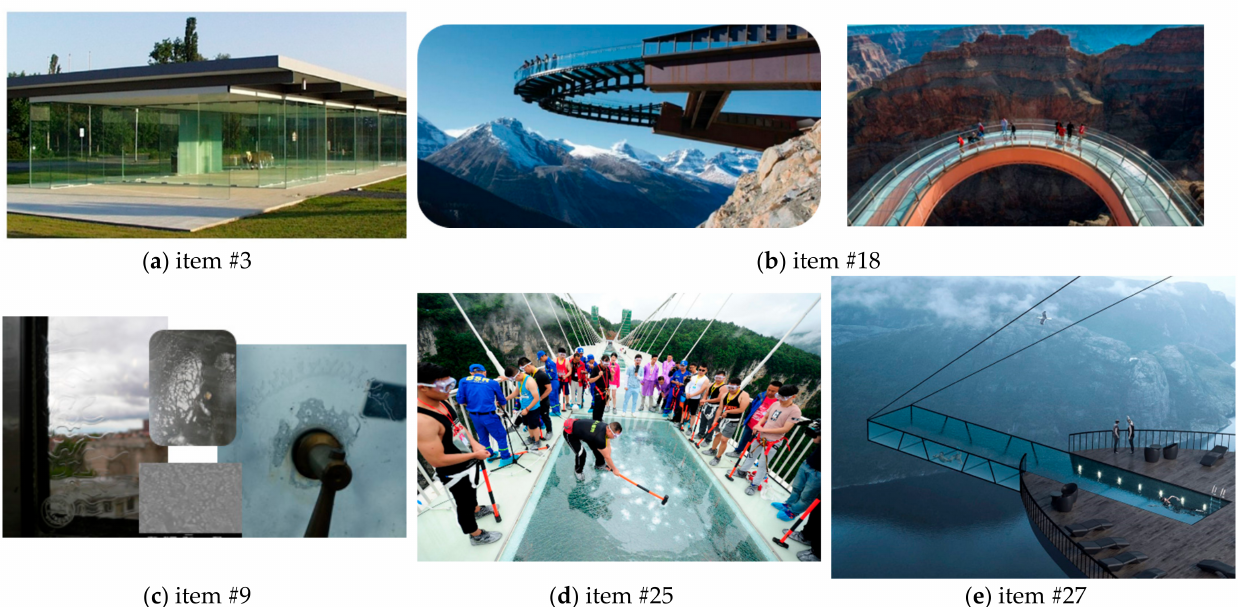
Figure 13. Static items with prevailing NEG reactions: ( a ) Glass Pavilion Rheinbach, DE (adapted from [46], © F. Wellershoff); ( b ) skywalk (Jasper National Park, CA; (adapted from [47], © Getty Images); ( c ) delamination (adapted from [48] under the terms and permissions of a CC-BY license and adapted from [49], Copyright 2021 Elsevier®, license number 5067511162164); ( d ) Zhangjiajie bridge, Hunan, CN (adapted from [50], © VCG via Getty Images); ( e ) cliff concept boutique hotel (adapted from [51], © Hayri